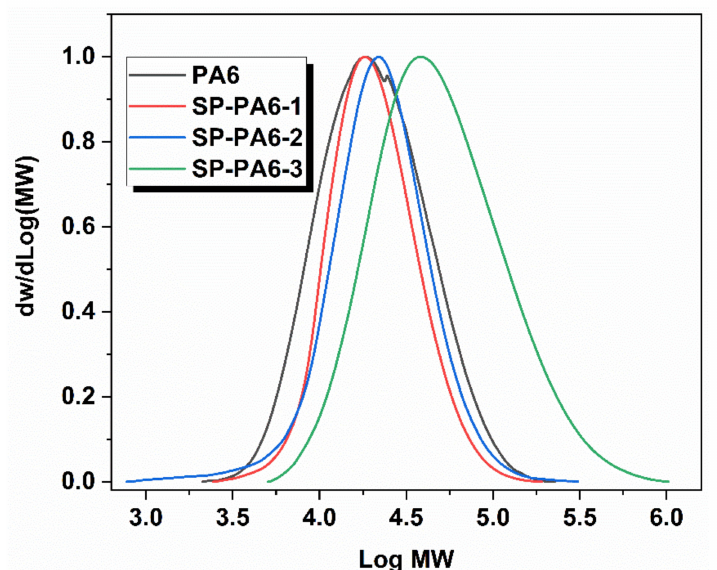
Figure 2. GPC curves of pure PA6 and photochromic